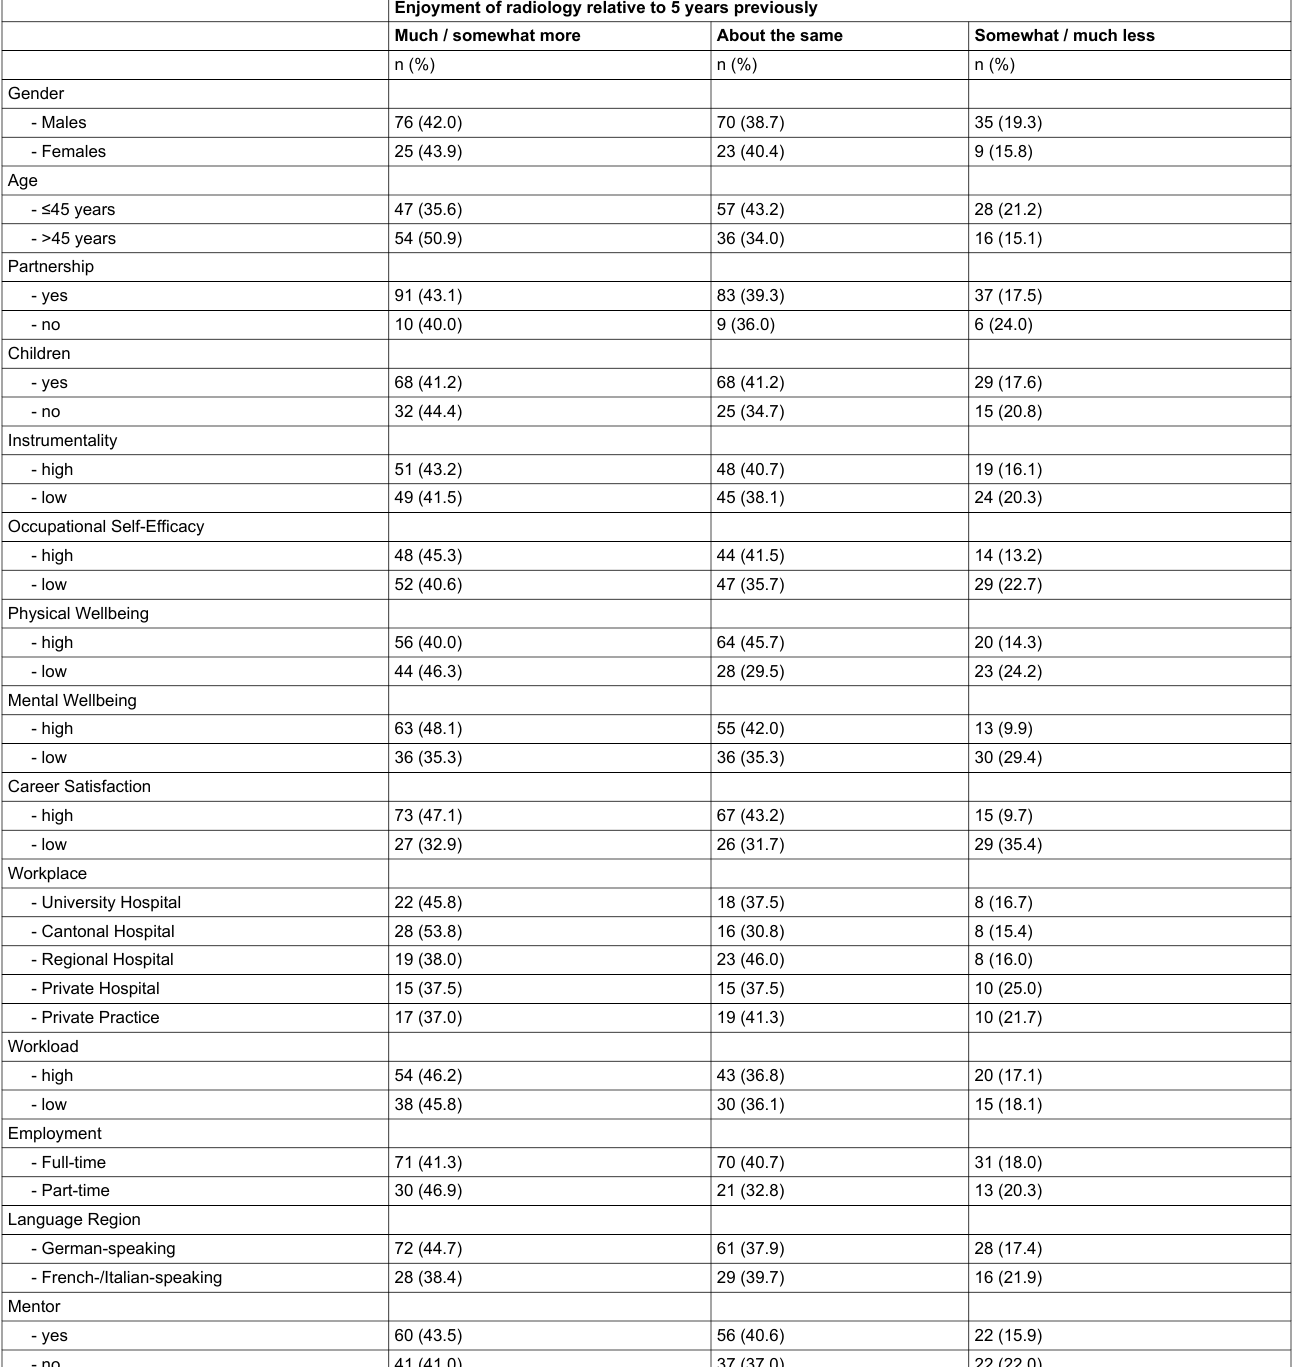
Table 2: Level of enjoyment of radiology relative to 5 years previously dependent on person- and workplace-related factors (n = 238: 181 males, 57 females) 1 . Enjoyment of radiology relative to 5 years